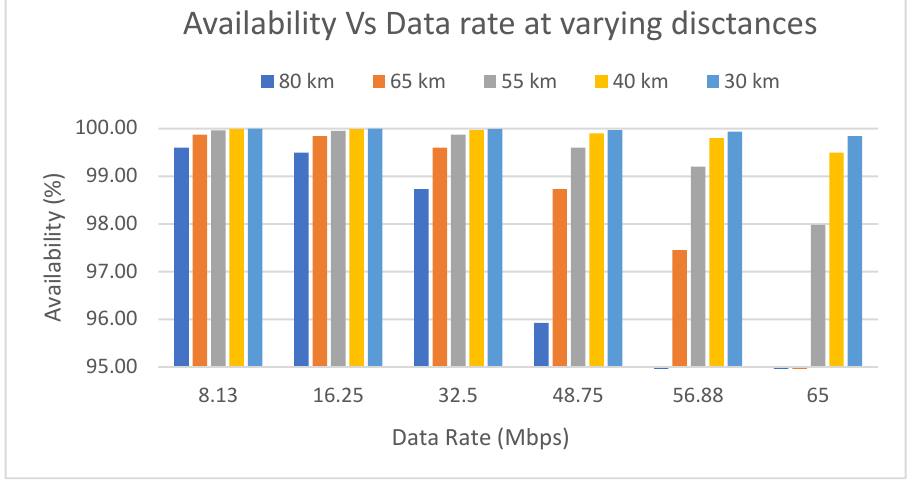
Figure 9. Beyond the horizon, backhaul availability vs. capacity of the communication link.